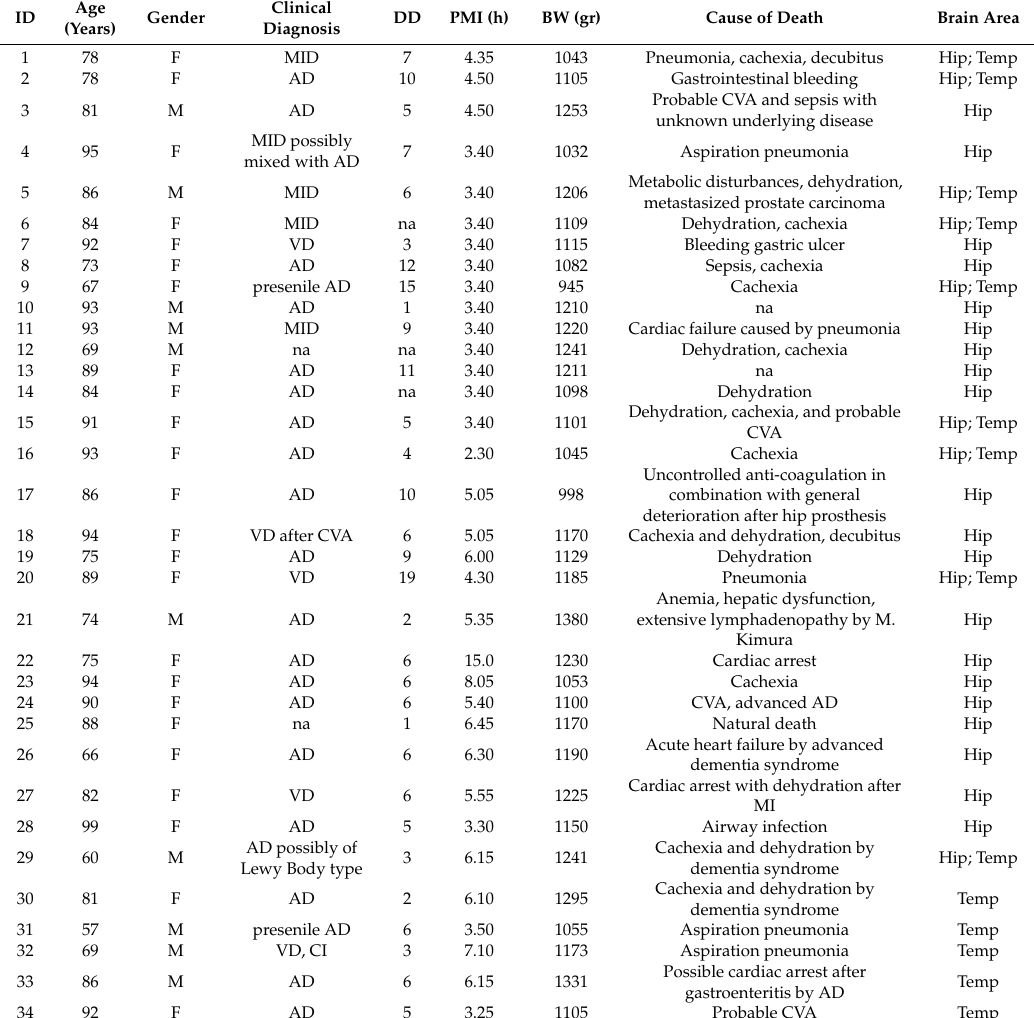
Table 1. Demographic and clinical features of demented